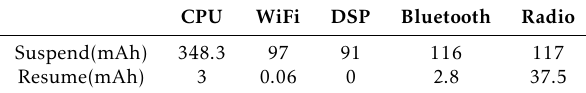
Table 2. Different Power Consumption under suspend/resume